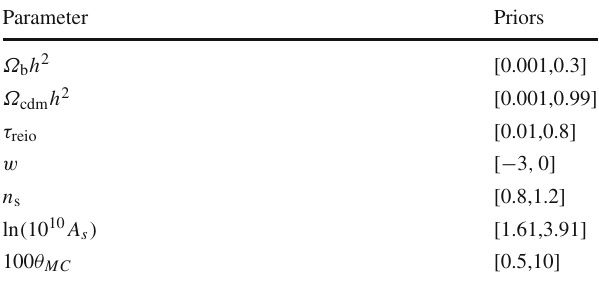
Table2 Flatpriors onthecosmologicalparametersusedinourMCMC analysis